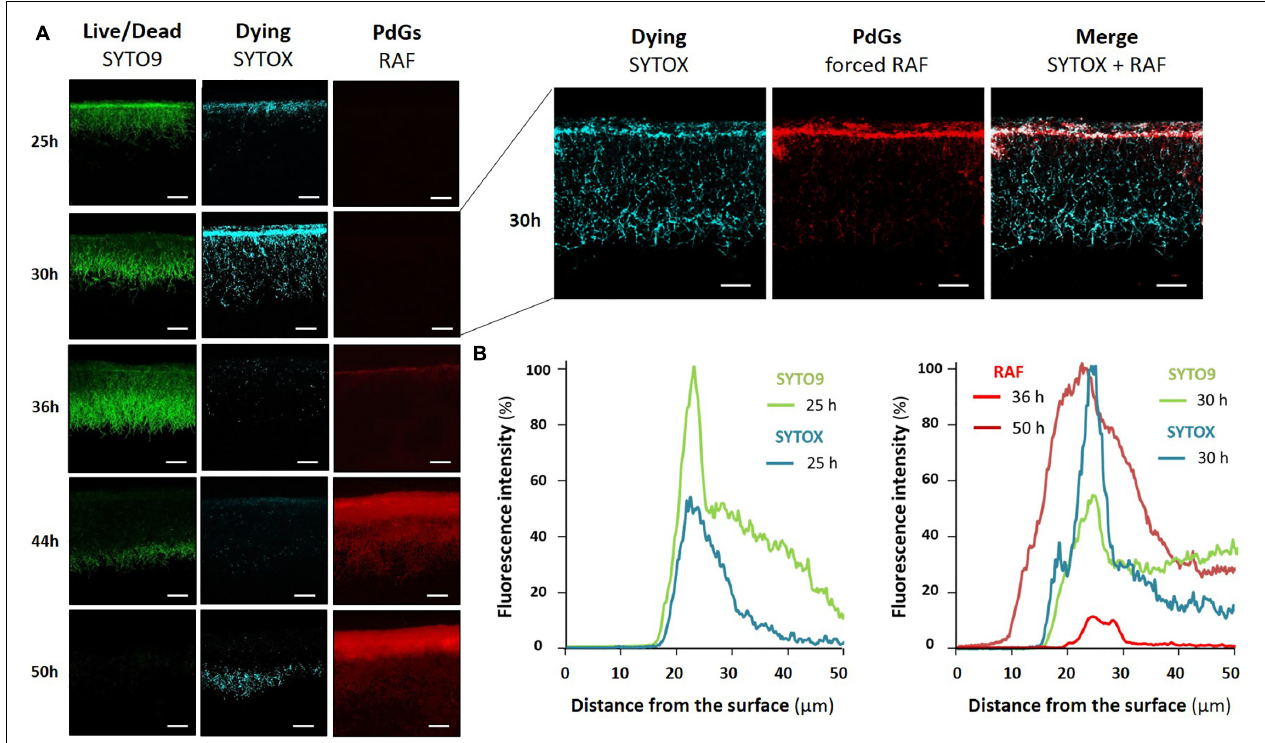
FIGURE 2 | Spatio-temporal occurrence of production of PdGs and cell death in S. coelicolor . (A) Images represent cross-sections of confluent lawns of S. coelicolor M145 grown on R2YE agar plates. Maximal fluorescence intensity associated with PdG biosynthesis (RAF), dying filaments (SYTOX-staining, blue-colored), or live/dead filaments (SYTO9-staining, green colored), was reached after 50, 30, and 25 h of growth, respectively. The voltage on the photomultiplier tubes (PMT) for RAF was fixed to 600 V. On the right panels the PMT was increased to 680 V in a 30 h old cross section in order to visualize RAF showing early PdG production that starts from the thin band of cell death. Bars, 40 µ m. (B) Quantification of RAF, SYTO9, and SYTOX fluorescence signals across the first 50 µ m of the S. coelicolor culture. Note that the peak of maximum RAF, SYTO9, and SYTOX occurred in the same thin band at a distance of about 20–30 µ m from the surface of the culture.